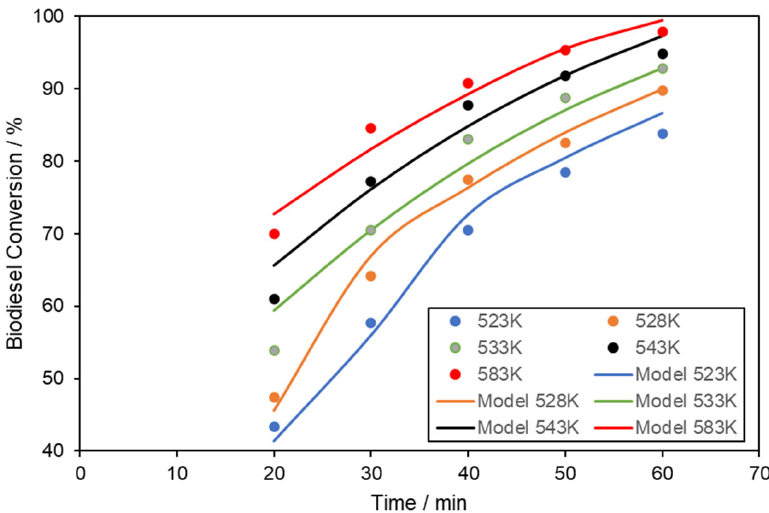
Figure 4. Effect of temperature and reaction time on oil conversion to biodiesel for constant methanol-to-oil ratio of 10, using oil derived from Schizochytrium limacinum algae. Experimental data were taken from [36].